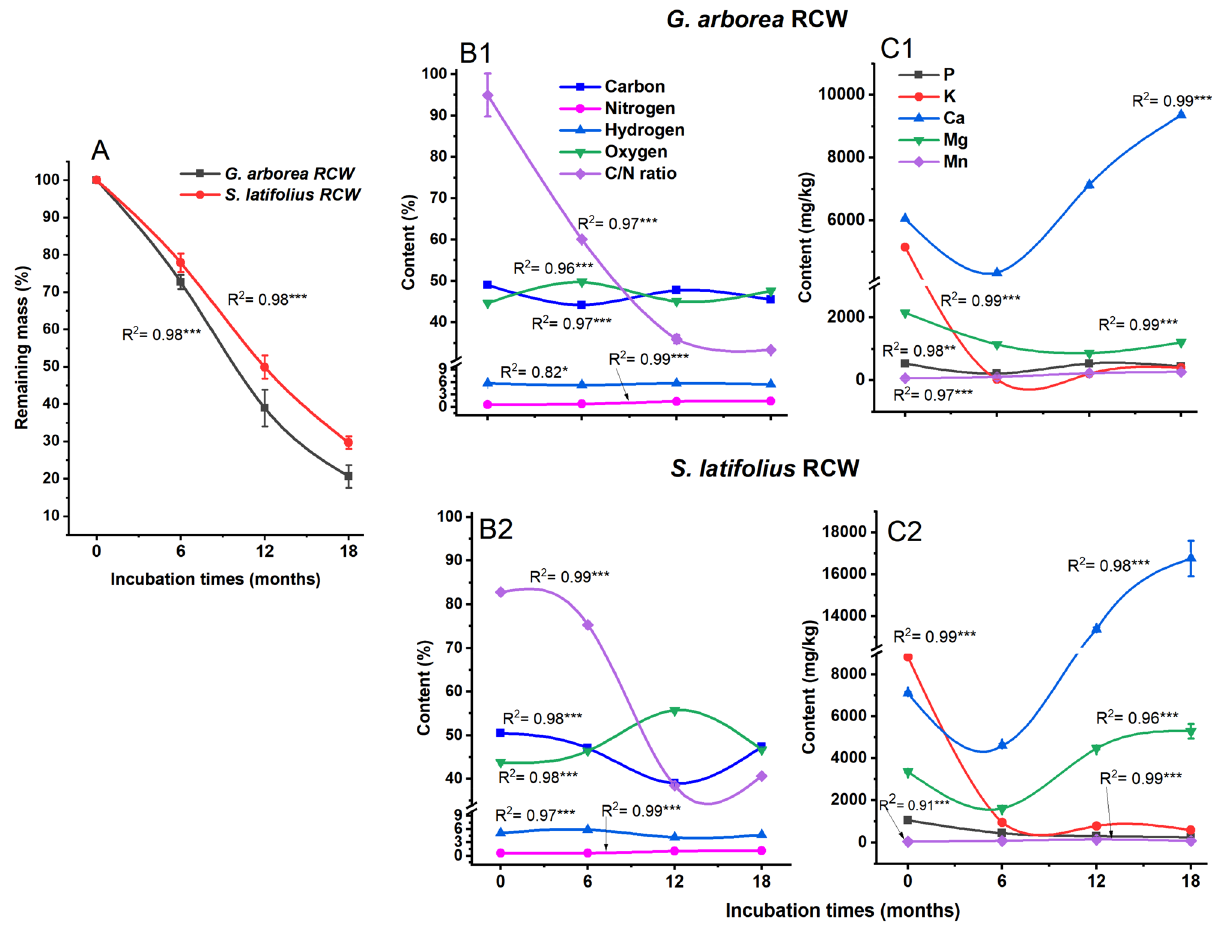
Figure 2. Content of chemical constituents of RCW of G. arborea ( A , B1 , C1 ) and S. latifolius ( A , B2 , C2 ) after 0, 6, 12 and 18 months of decomposition in soils. EtOH-Tol Ext, Ethanol-toluene extractives; RCW, ramial chipped wood, All contents are expressed as means ± standard errors (error bars) in triplicate. ***Contrasts significant at the 0.001 level, ns = not